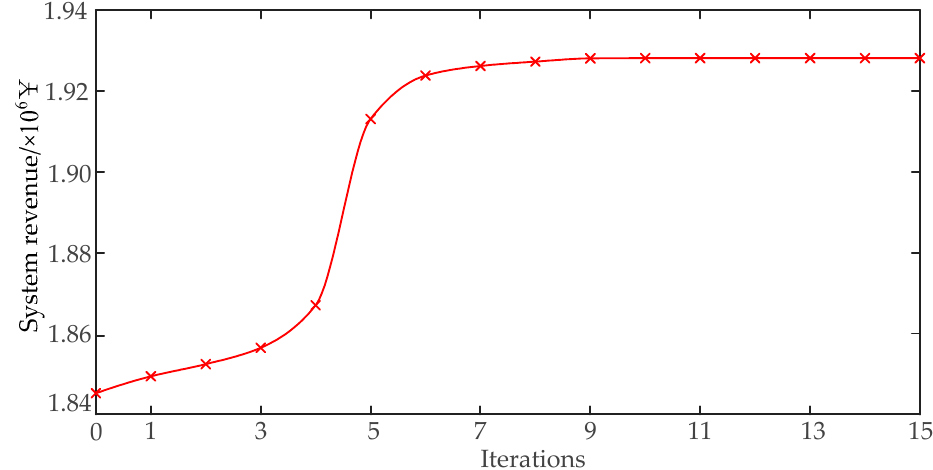
Figure 14. Changing of the objective function versus the number of iterations.